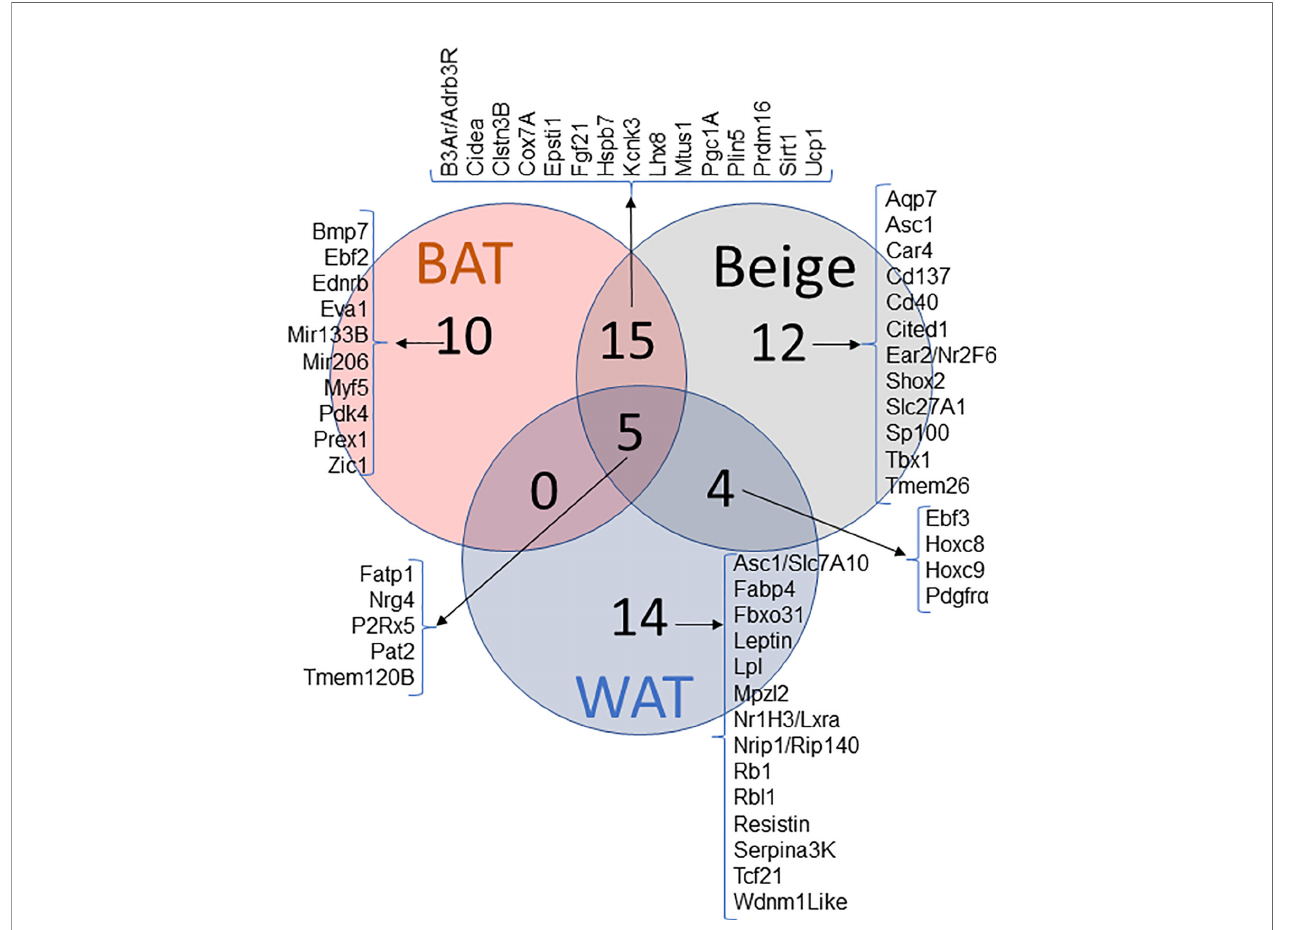
FIGURE 1 | Venn diagram of WAT, BAT and Beige markers and their pattern of expression. Genes reported in literature as a marker for WAT, BAT and BeAT. Venn diagram represents the commonality and uniqueness of certain